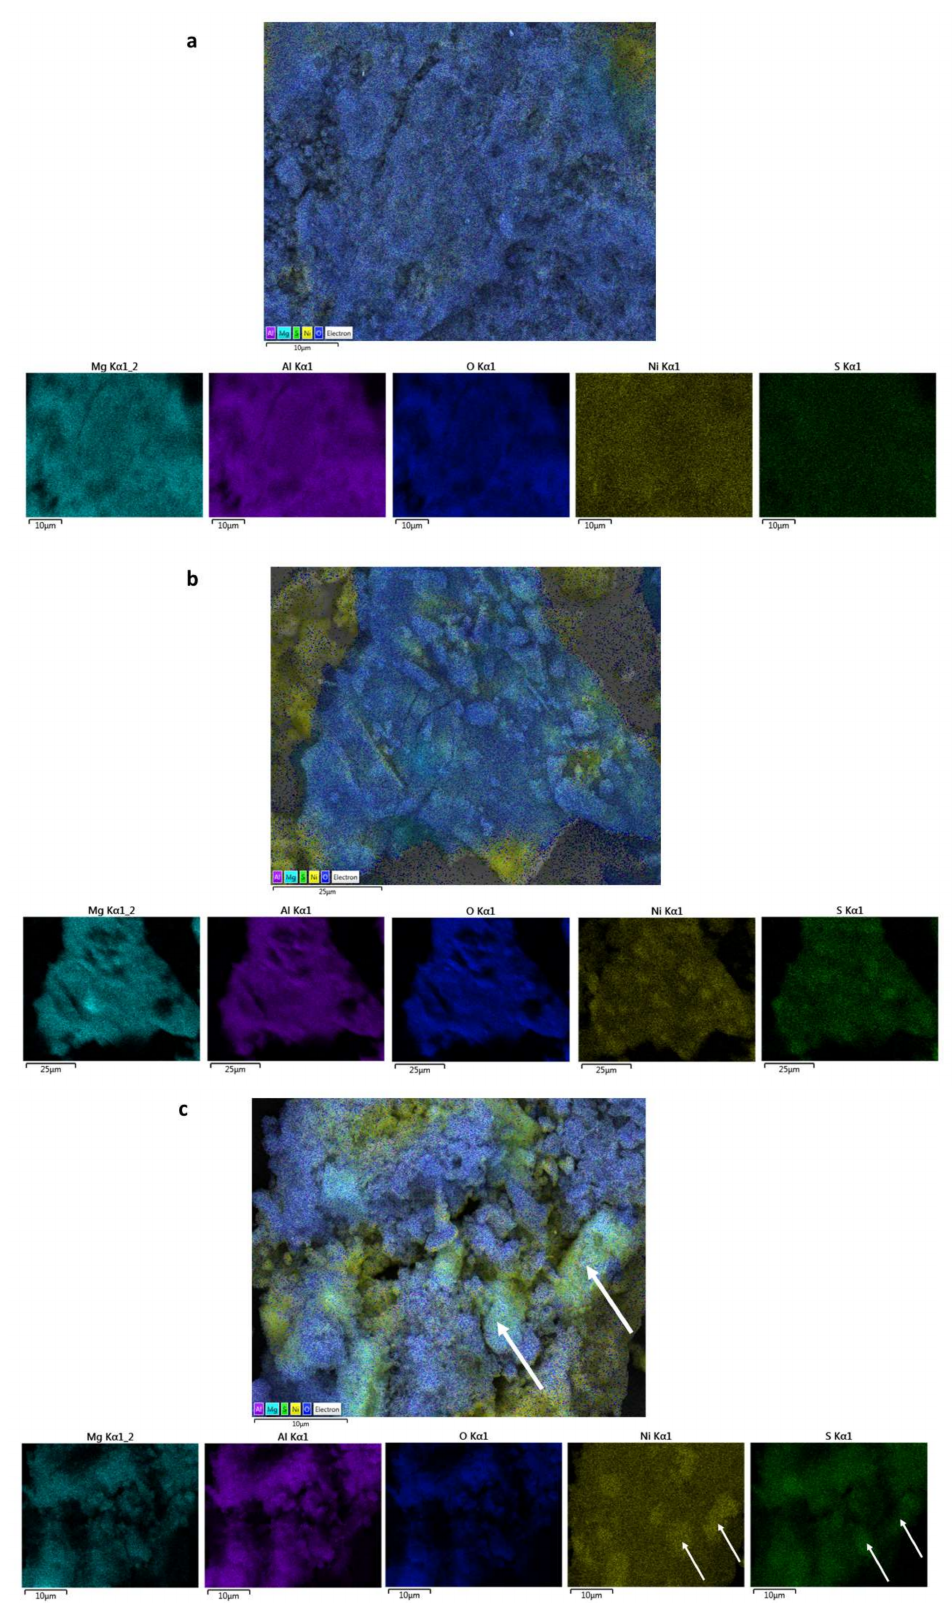
Figure 6. X-ray mapping of ( a ) Ni/MgAl 2 O 4 -S3-200, ( b ) Ni/MgAl 2 O 4 -S3-400 and ( c ) Ni/MgAl 2 O 4 - S3-550. Nickel-sulfided species indicated by white